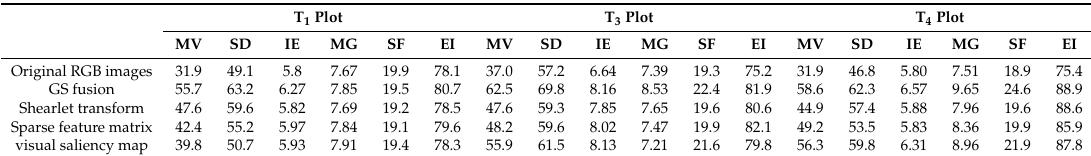
Table 2. Results of image display effect evaluation before and after fusion with different fusion methods. Mean Value (MV); Standard Deviation (SD); Information Entropy (IF); Mean Gradient (MG); Spatial Frequency (SF); Edge Intensity (EI). T 1 Plot T 3 Plot T 4 Plot MV SD IE MG SF EI MV SD IE MG EI MV IE EI Original RGB images 31.9